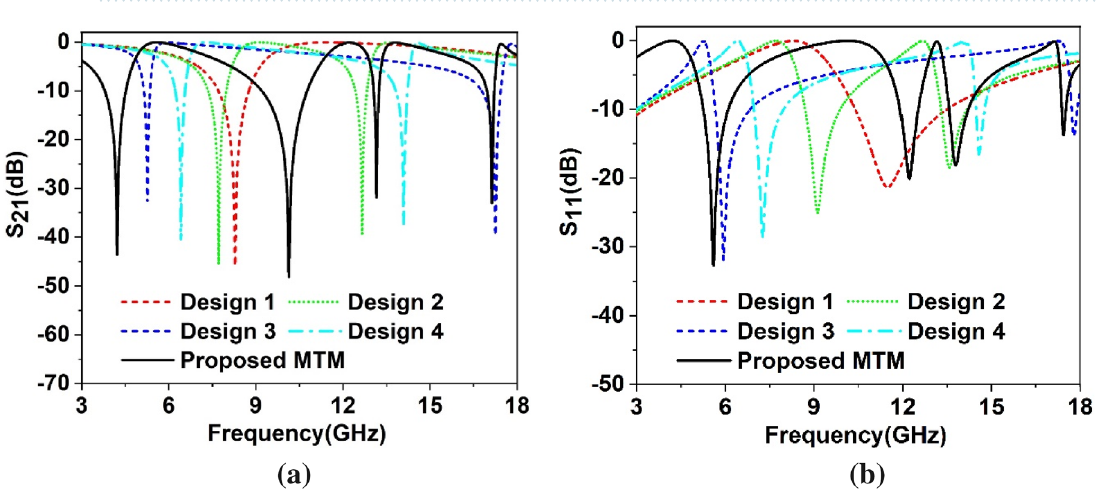
Figure 4. Scattering parameters for evolution steps towards the proposed unit cell: ( a ) Transmission coefficient